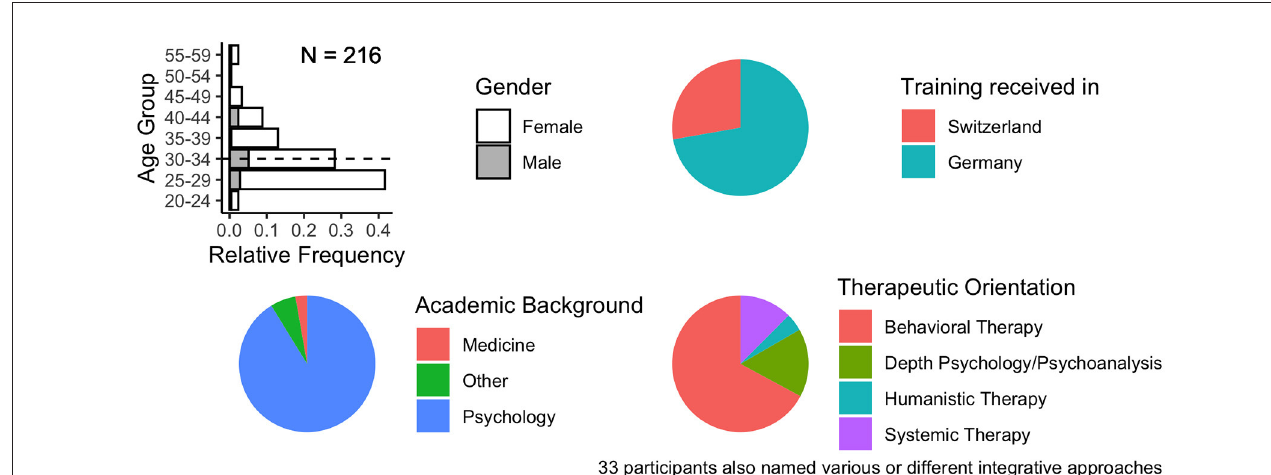
FIGURE 1 | Participant Demographics.